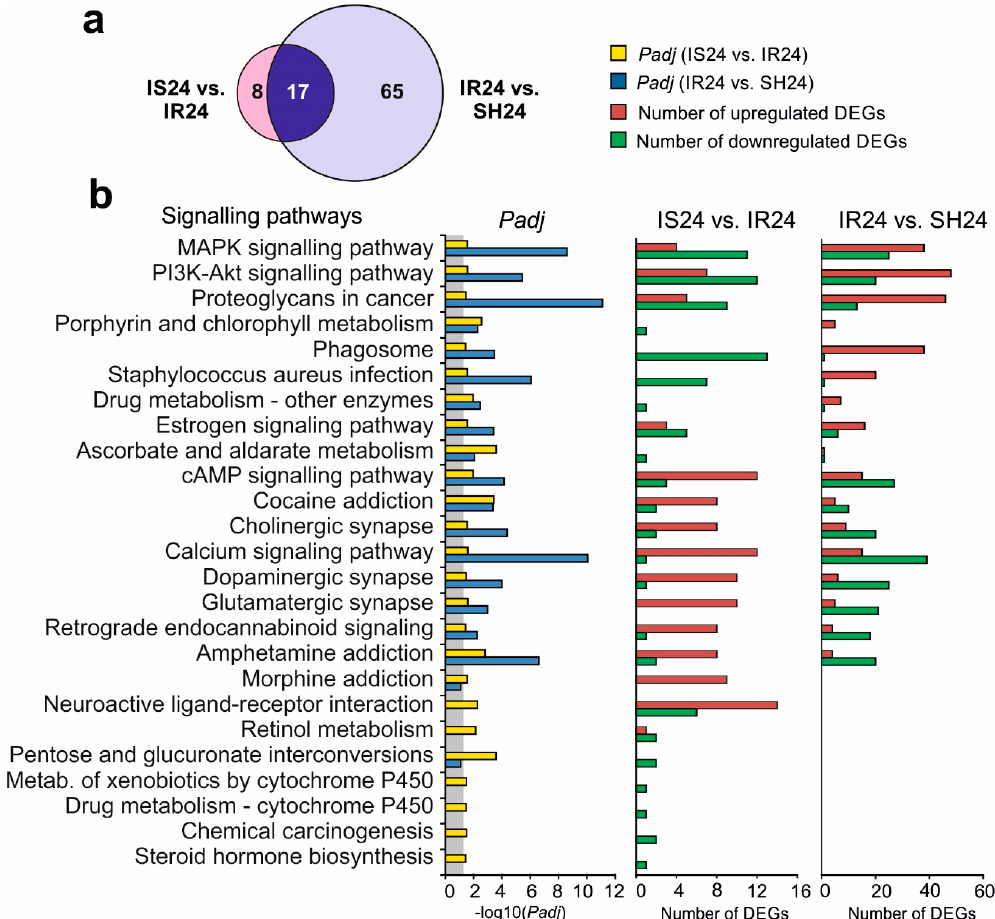
Figure 4. Analysis of the signalling pathways associated with DEGs at 24 h after tMCAO. ( a ) The numbers of signalling pathways overlapped in two pairwise comparisons: IS24 versus IR24 and IR24 versus SH24. ( b ) KEGG database analyses of DEGs in two pairwise comparisons IS24 versus IR24 and IR24 versus SH24 was carried out according to the DAVID database. The number of upregulated and downregulated DEGs, as well as the p -values adjusted using the Benjamini–Hochberg procedure ( Padj ), are shown. Only those genes and signalling pathways whose Padj < 0.05 were selected for analysis. Padj ≥ 0.05 are enclosed in the gray background.